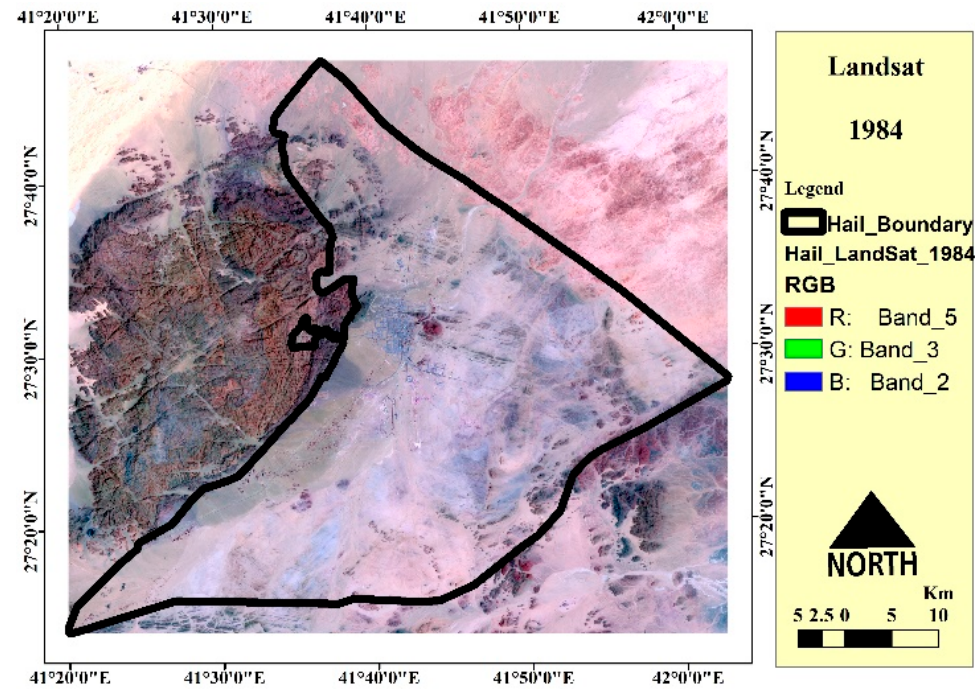
Figure 5. S atellite image (Landsat 1984) for the study area. Figure 5. Satellite image (Landsat 1984) for the study